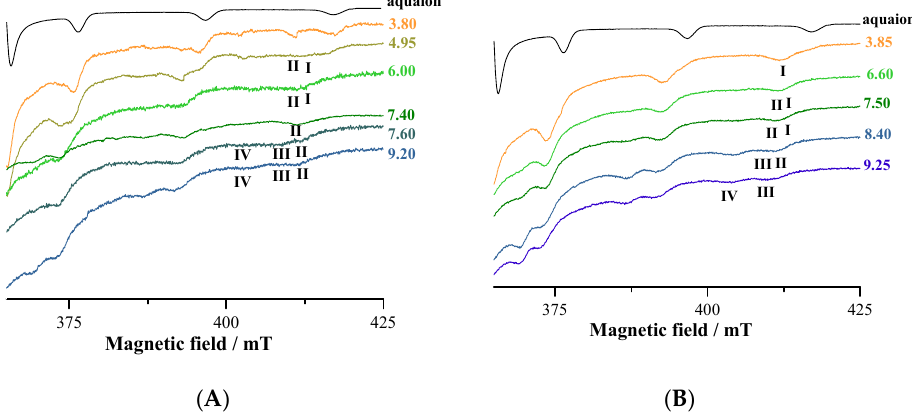
Figure 5. High-field region of the anisotropic X-band EPR spectra recorded on frozen solutions (120 K) of V IV O 2+ -L9 system at 1:1 ( A ) and 1:2 ( B ) molar ratio at V IV O 2+ concentration 2 mM at different pH.